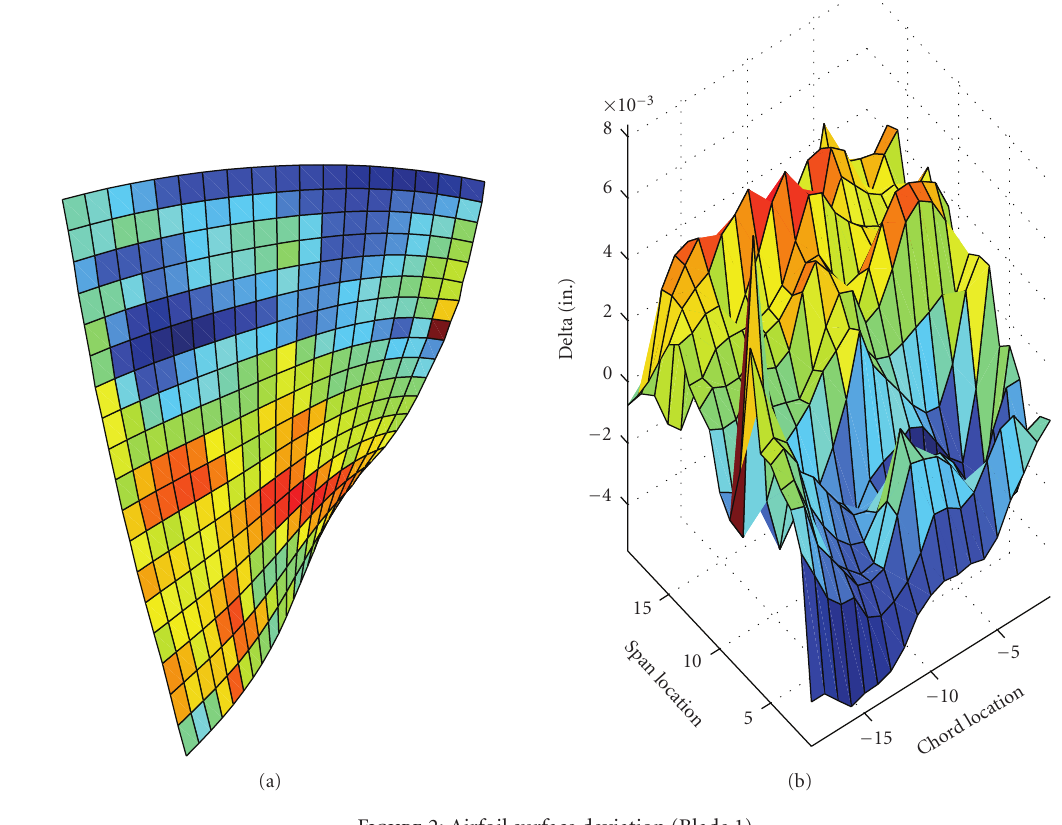
Figure 2: Airfoil surface deviation (Blade 1).